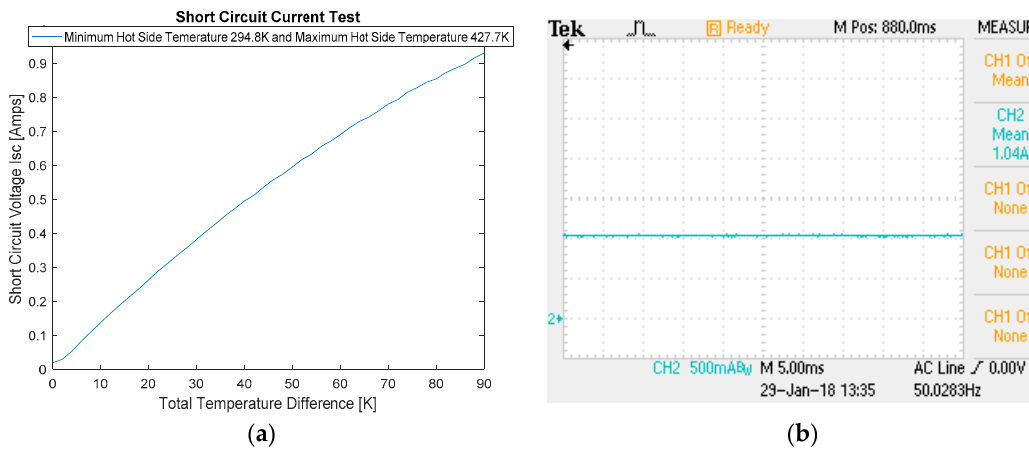
( b ) Figure 11. ( a ) Effect of temperature difference ( Δ𝑇 ) on open circuit voltage ( V oc ) and ( b ) oscilloscope DC V oc and I oc response at 418.2 K (or Δ𝑇 of 92 K). Short Circuit Current Test ( 𝐼 (cid:3046)(cid:3030) ) Figure 12a shows the maximum short circuit current ( I sc ) of 0.93 A that was obtained at a temperature difference of 90 K, without damaging the thermoelectric device. A series of short circuit tests were conducted under the same temperature gradients, and it was found that the maximum I sc was recorded with was 1.04 A, as shown in Figure 12b. As the short circuit current test was carried out after the open circuit voltage test, and it was found out that the performance of the TEG module was not the same as when the open circuit voltage test was carried out in the first place. This is mainly due to the bonding of Bi 2 Te 3 with electrodes, which expand due to the current and heat source causing heat, leading to tensile stresses. Such slight deviation of performance can be observed that, during